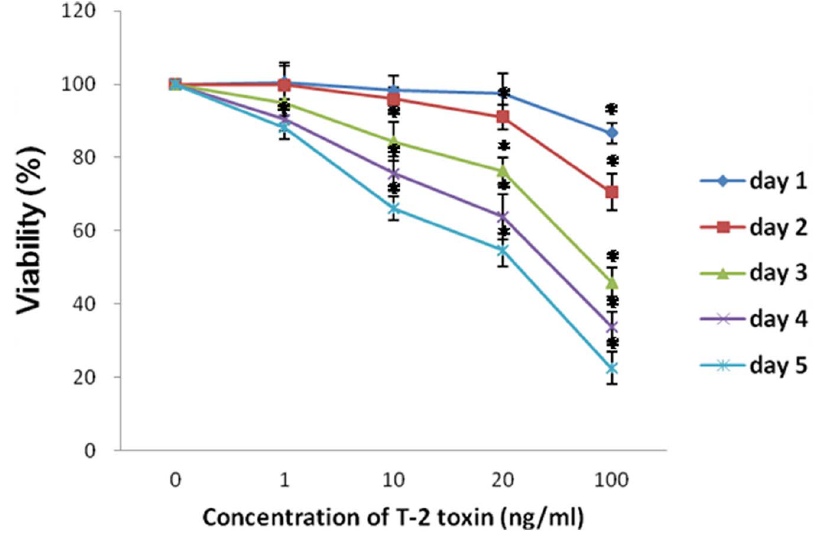
Figure 1. Effects of different concentrations of T-2 toxin on the cellular viability of chondrocytes were estimated by MTT reduction. Cells were incubated in absence or presence of several T-2 toxin concentrations for different time periods (1–5 d). * P , 0.05.